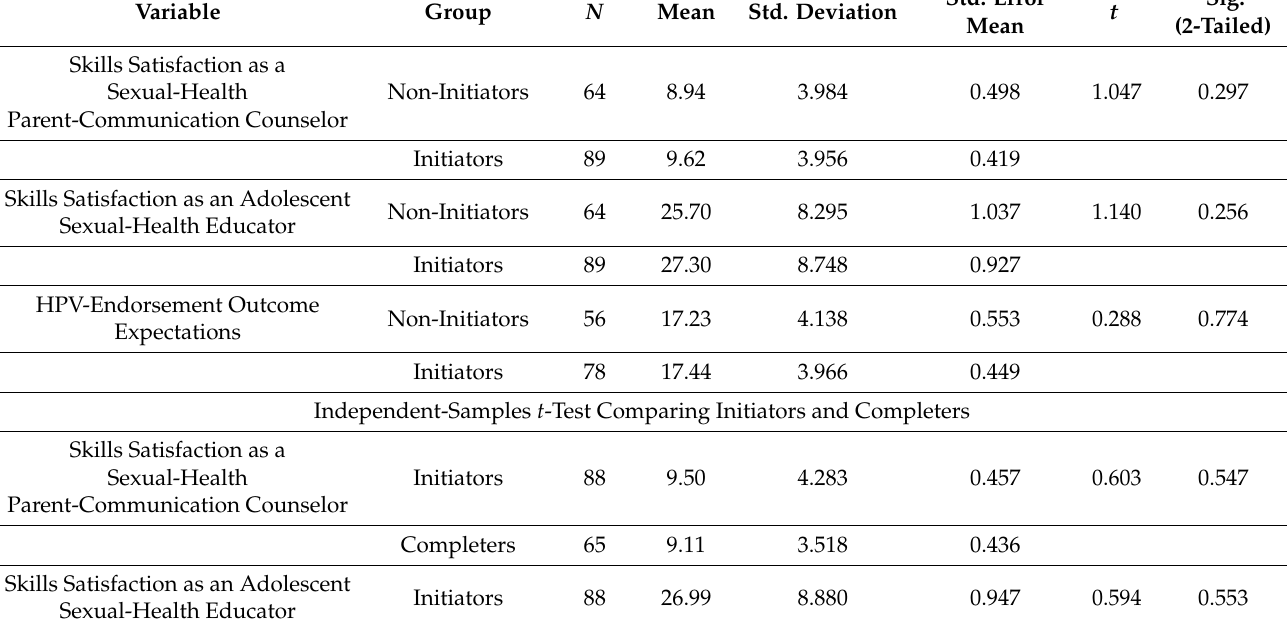
Table 3. Independent-samples t -test comparing non-initiators and